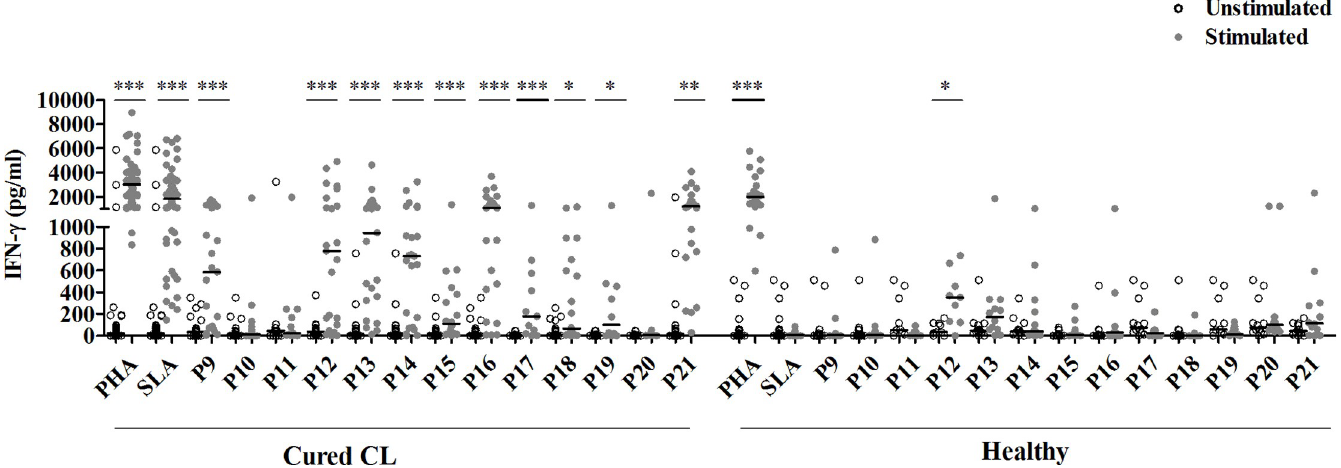
Fig 3. IFN- γ responses to pools composed of both HLA-I and HLA-II peptides. IFN- γ was quantified by ELISA, in culture supernatants of PBMC from cured CL subjects (N = 23) or healthy individuals (N = 12) stimulated with peptide pools (1 μ M/peptide) composed of both HLA-I and HLA-II peptides, for 10 days. PHA and SLA were used as positive controls (10 μ g/ml). Horizontal bars represent median values. Statistical significance was assigned to a value of p < 0,05 ( � p < 0.05, �� p < 0.01, ��� p <